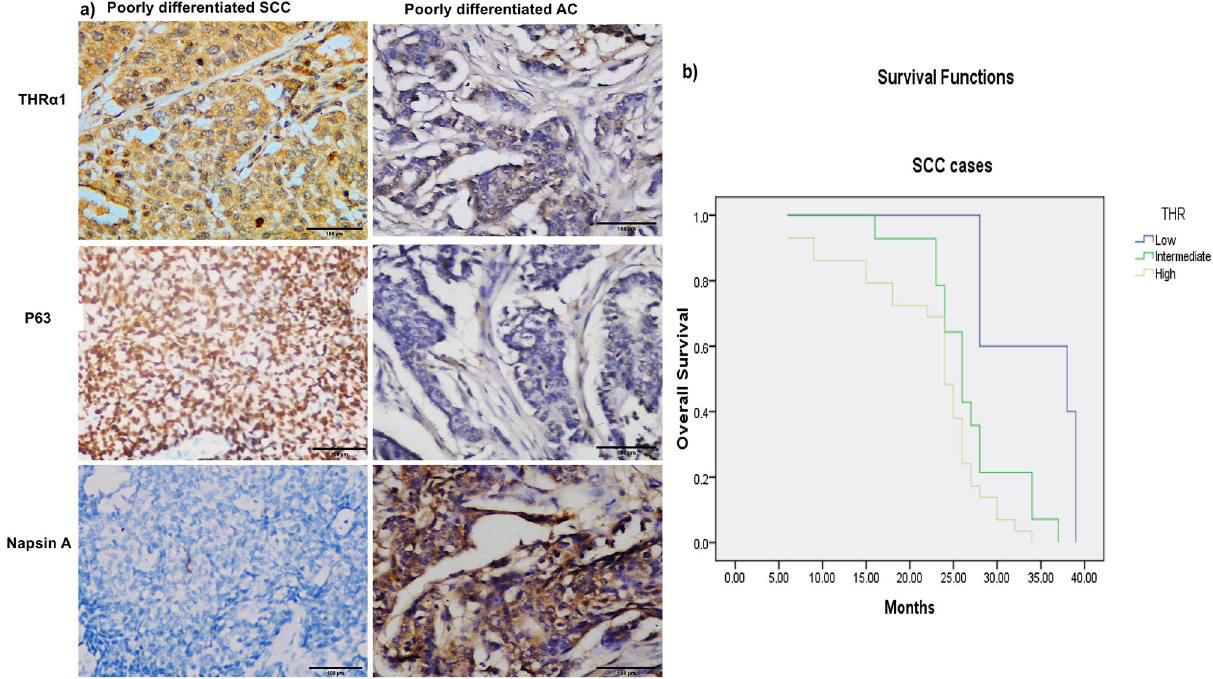
Figure 2. High THRα1 expression is a diagnostic marker for SCC in poorly differentiated human NSCLC tissues and is associated with shorter OS. ( a ) Poorly differentiated NSCLC tissues showing high THRα1 protein expression, positive nuclear P63 and negative Napsin A confirming that the case is SCC and low THRα1 protein expression, negative nuclear P63 and positive Napsin A confirming that the case is AC. (b ) Kaplan Meyer curve showing that THRα1 expression is associated with poor